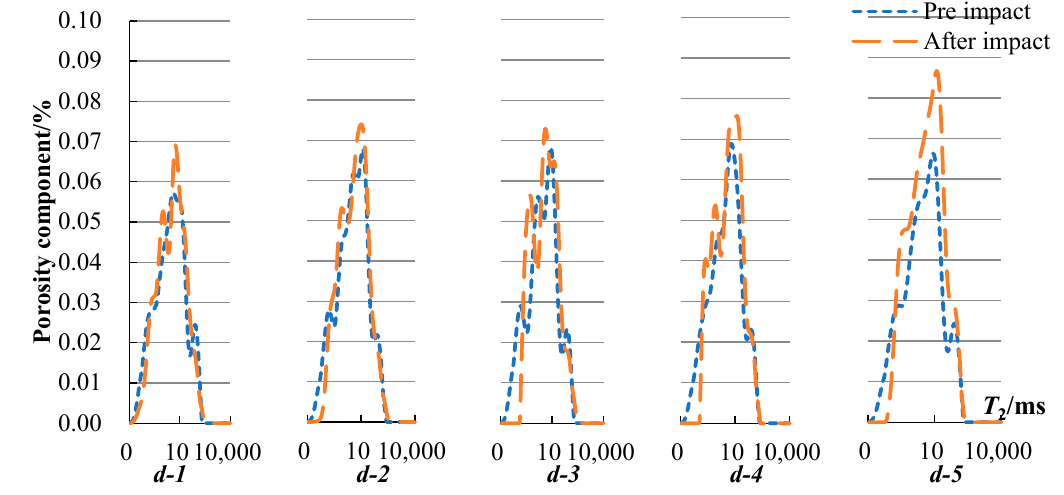
Figure 9. T 2 spectrum curves of dry samples.